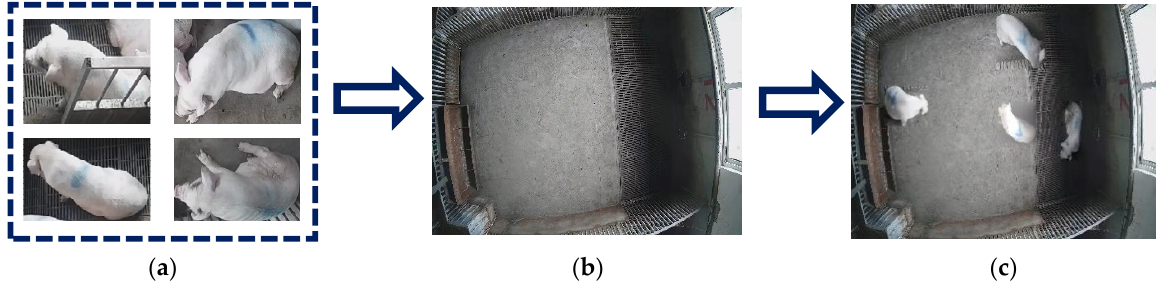
Figure 5. Schematic of simplified copy-paste: ( a ) crops from image with sitting posture; ( b ) back- ground image of empty pen; ( c ) image with 4 sitting posture labels after copy-paste is performed.